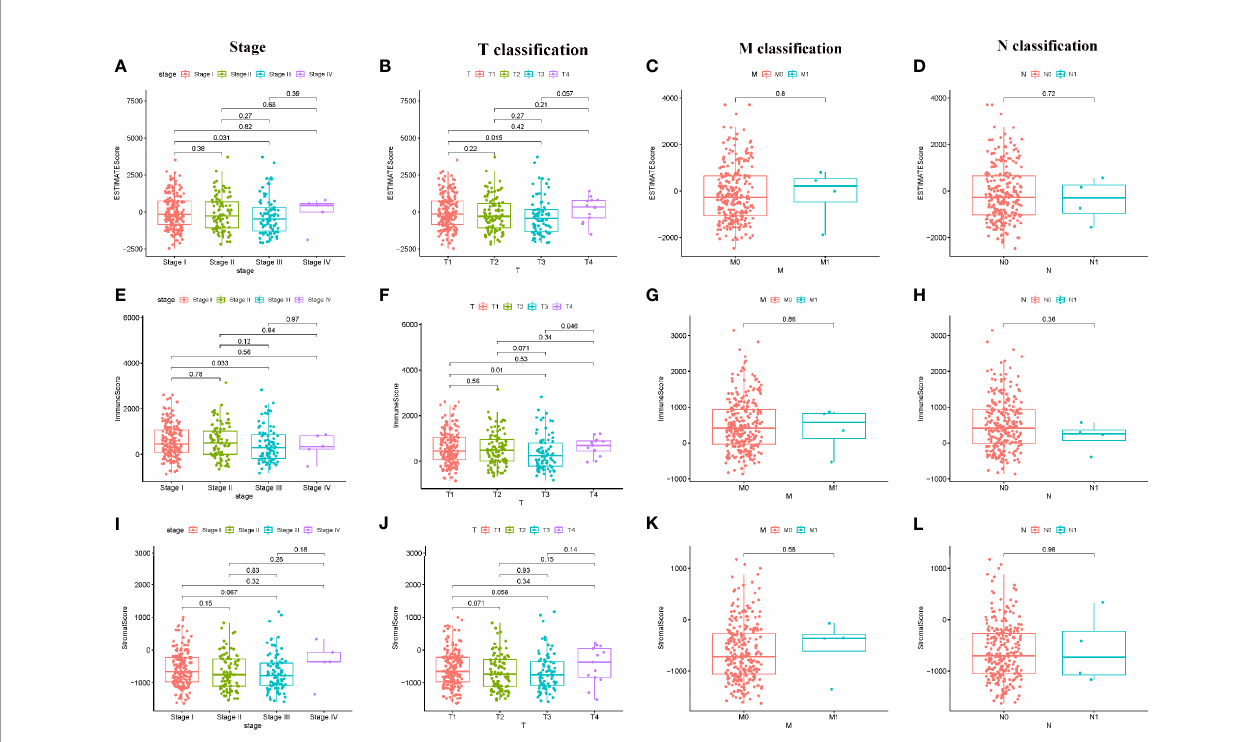
FIGURE 1 | Correlation of ESTIMATE Score, Immune Score, and Stromal Score with clinical characteristics. (A – D) Distribution of ESTIMATE Score in different stage and TMN classi fi cation; (E – H) Distribution of Immune Score in different stage and TMN classi fi cation; (I – L) Distribution of Stromal Score in different stage and TMN classi fi